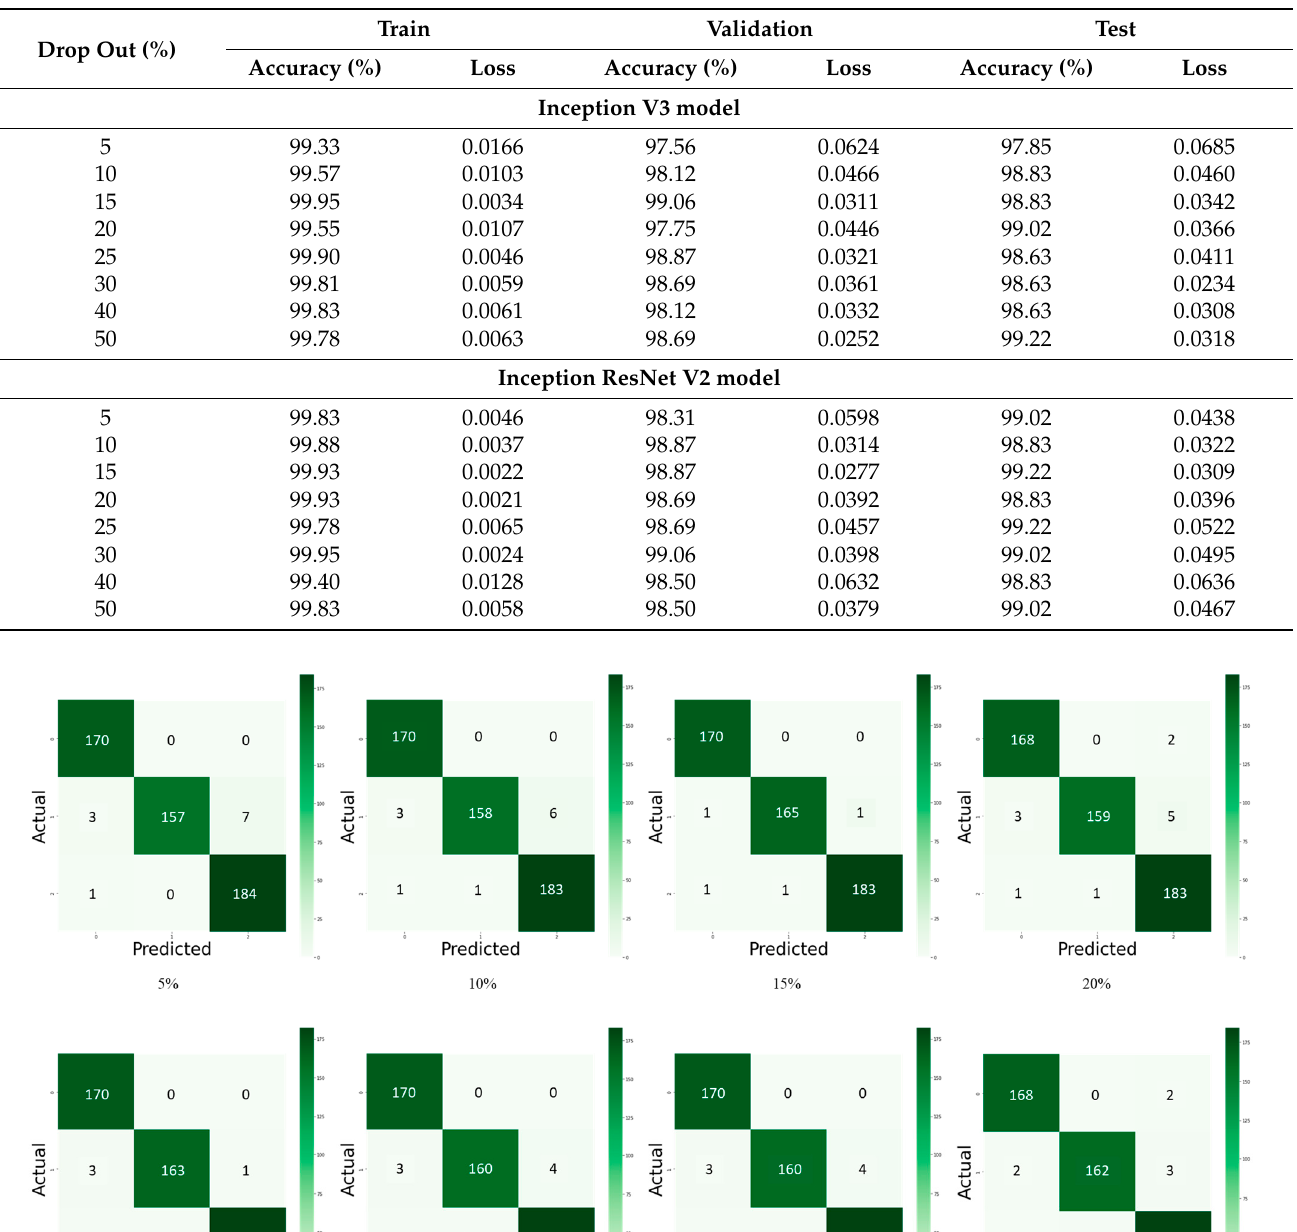
Table 5. Accuracy and loss for the training, validation, and testing phases of Inception V3 and Inception ResNet V2 models with different dropout values.